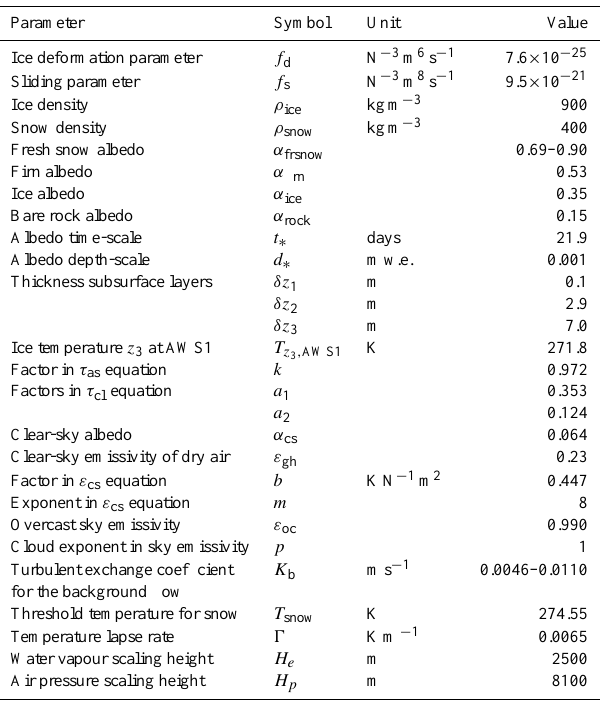
Table 1. Parameter values used in this study. The value for 0 listed here is used for extrapolation over the ice cap, for extrapo- lation of air temperature data to the ice cap, different values are used (Sect.